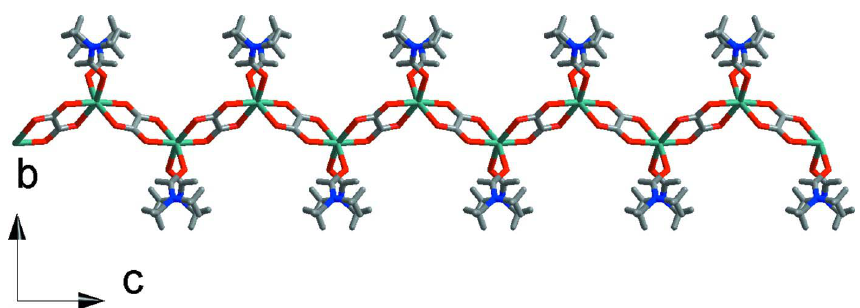
Figure 2 A projection in the bc -plane showing the one-dimensional chain propagating along the c -direction. catena -Poly[[bis( N , N ′ -dimethylformamide)cadmium(II)]- µ -oxalato] Crystal